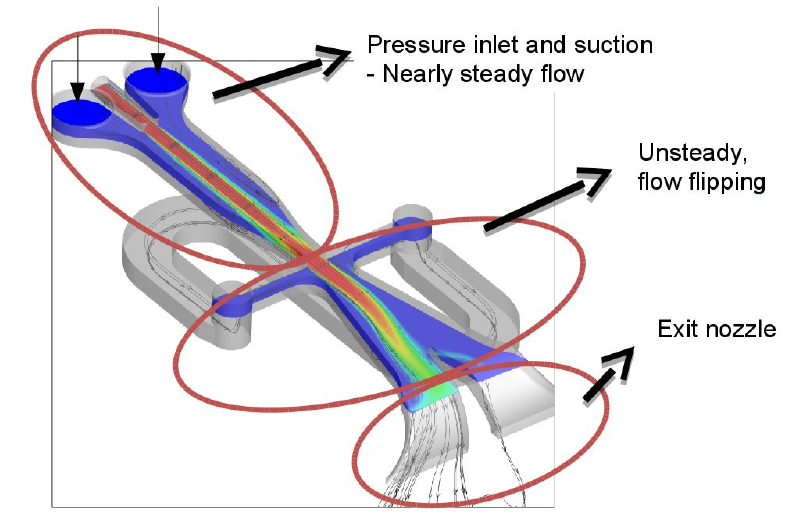
Figure 4. Snapshot of typical flow inside the SaOB actuator. The main areas, with respect to the character of the flow, are highlighted, adopted from